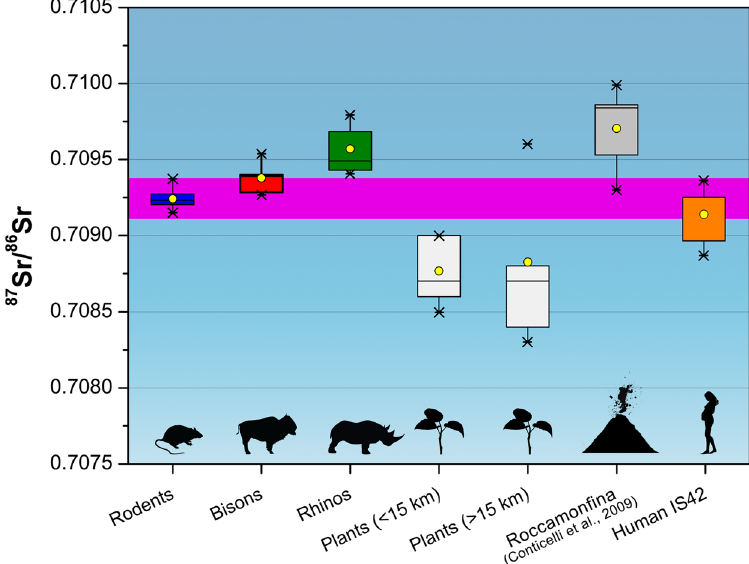
Figure 3. Strontium isotope data for human, fauna and modern samples of the Isernia La Pineta site and surroundings. The magenta area is the 2 σ of the rodent teeth Sr isotope composition as the local 87 Sr/ 86 Sr reference value. Drawing by Federico Lugli (INKSCAPE 0.92,